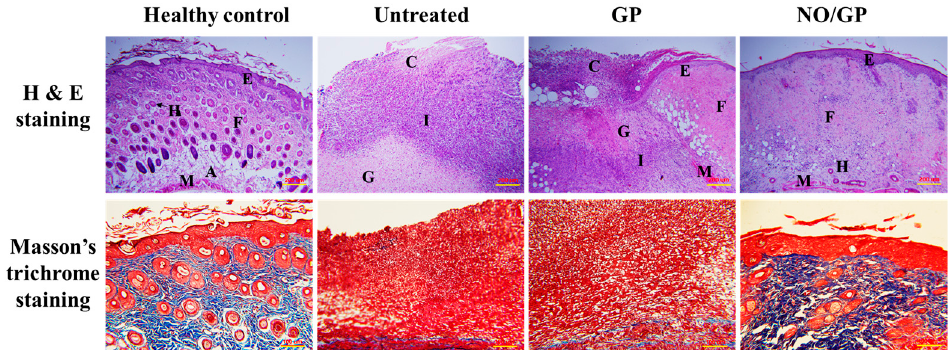
Figure 8. H&E (hematoxylin and eosin) and Masson’s trichrome straining of wound tissues from P. aeruginosa -challenged full-thickness wound mice threated with or without GP or NO/GP for 14 days. A: Adipose tissue; C: Cell debris; E: Epidermis; F: Fibrous tissue; G: Granulation tissue; H: Hair follicle; I: Immune cells; M: Muscle. Scale bar represents 200 and 100 μ m for the H&E and Masson’s trichrome images, respectively.